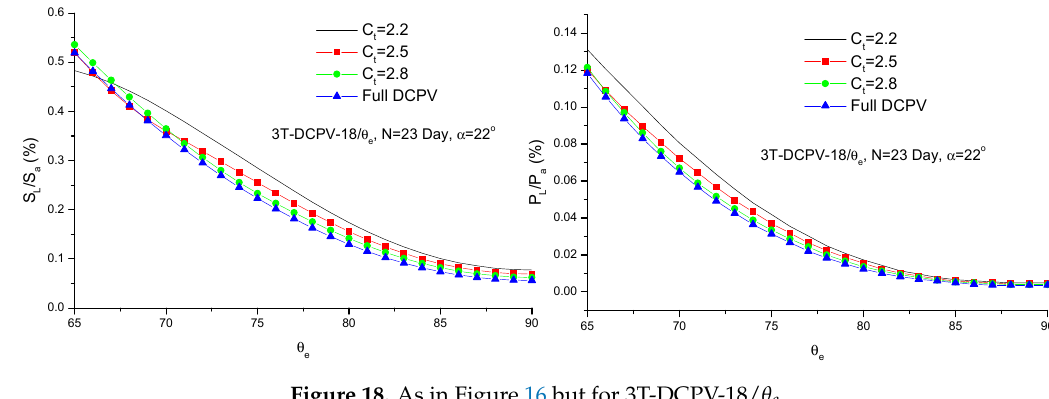
Figure 18. As in Figure 16 but for 3T-DCPV-18/ θ e Figure 18 . As in Figure 16 but for 3T-DCPV-18/ e